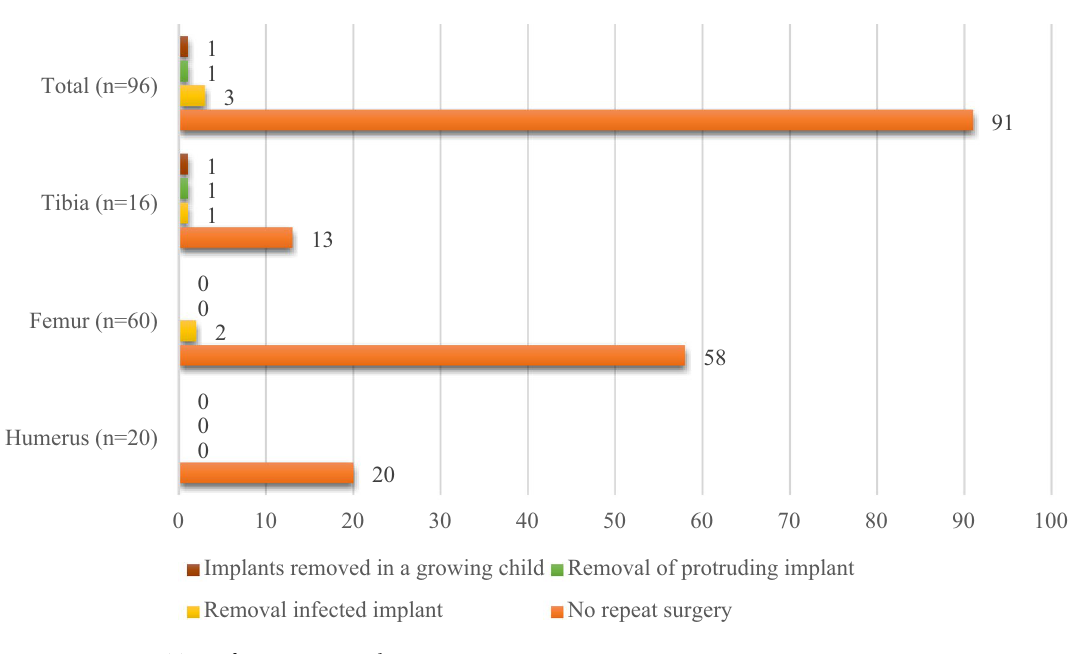
Figure 1. Infection types.